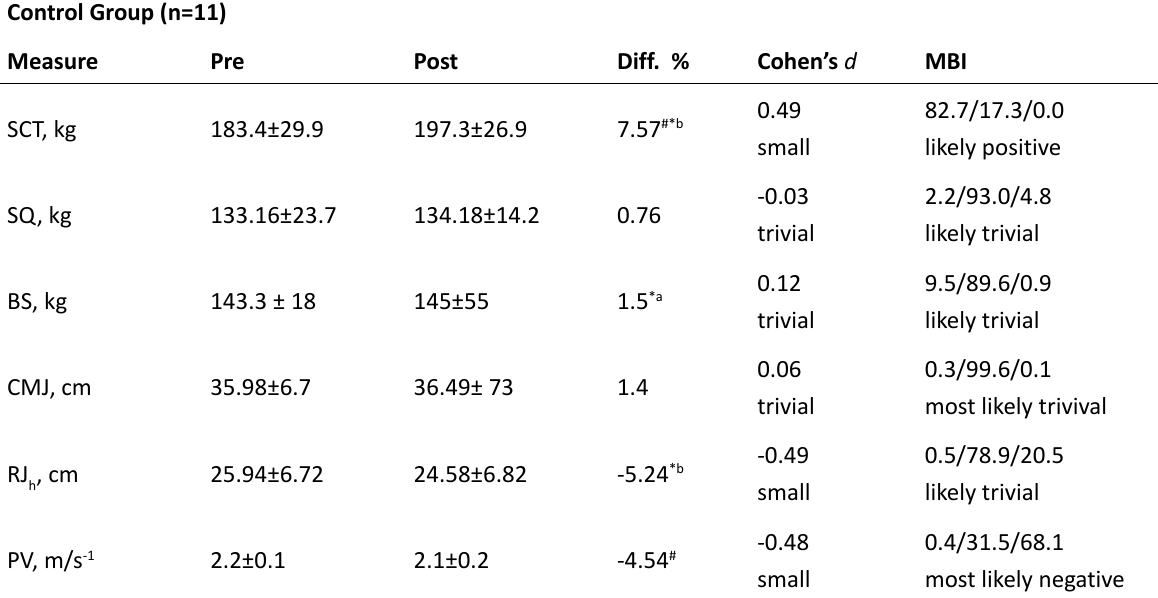
Table 5. Pretesting and Posttesting Results of Control Group Control Group